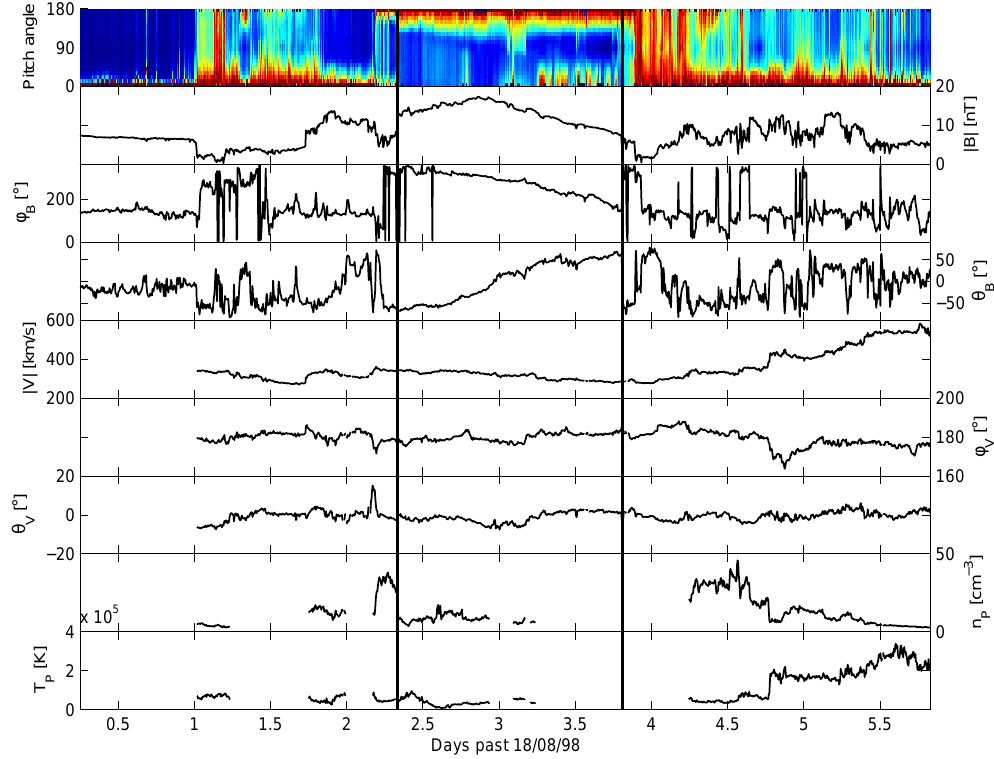
Fig. 6. Event A: A magnetic cloud observed in August 1998. The panels, from top to bottom are: The 272eV electron pitch-angle distribution, the magnetic field magnitude, the in- and out-of-ecliptic magnetic field angles, the solar wind flow speed, the in- and out-of-ecliptic solar wind flow angles, the proton density and proton temperature. The boundaries of the magnetic cloud are shown by the solid vertical lines. A kinematically-distorted flux rope model fit to the observed magnetic field time series (not shown), suggests the axis of the flux rope passed within r/r 0 = 0 . 12 of ACE at the point of closest approach. The dominant strahl, at 180 ◦ pitch angle, remains ∼ 75 ◦ width throughout the magnetic cloud. Thus the expected suprathermal electron signature of a magnetic flux rope is not present.